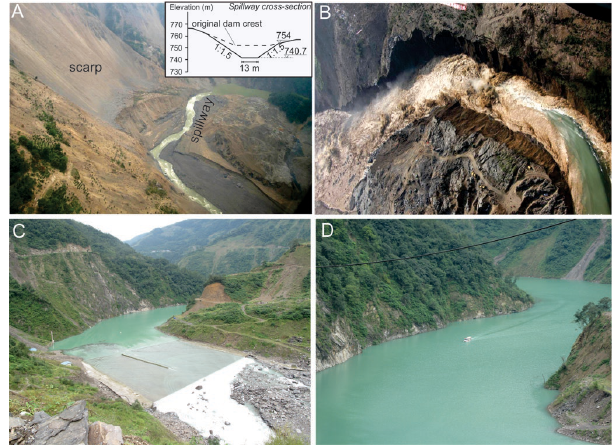
Fig. 5. (A) Helicopter view of the artificial spillway; inset shows the spillway cross-section; (B) releasing impounded water through the spillway, taken on 10 June 2008 when the discharge reached its peak (provided by Liu, N. from Ministry of Water Resources of the People’s Republic of China); (C) remaining dam; (D) Remaining lake, (C) and (D) were field photo taken in September 2011.